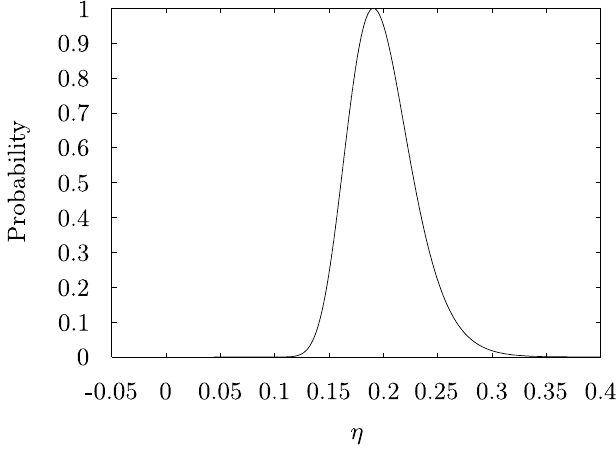
Figure 4: A plot of the posterior density of η .